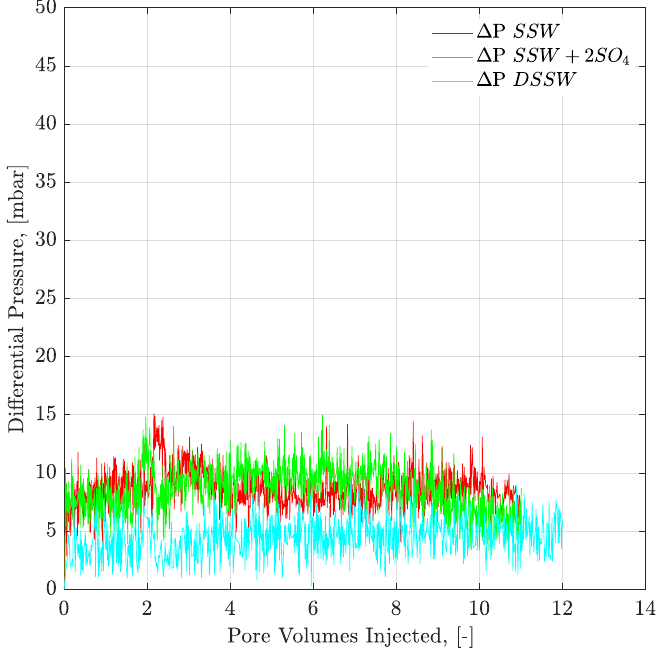
Figure 10. Pressure response of secondary mode brines flood through oil-wet micromodel at flux rate of 1 ft / day. ∆ P SSW represents the pressure drop for synthetic seawater and ∆ P SSW + 2SO 4 represents the pressure drop for synthetic seawater with doubled amount of sulfate and ∆ P DSSW represents the pressure drop for ten times diluted synthetic seawater.